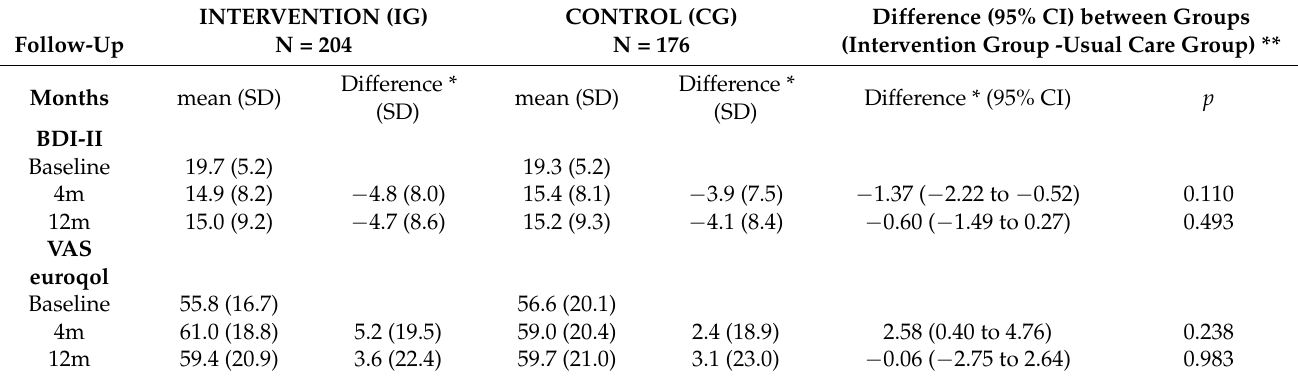
Table 3. Mean value (SD) of BDI-II and VAS Euroqol baseline, 4 m and 12 m. Changes BDI-II and VAS euroquol between